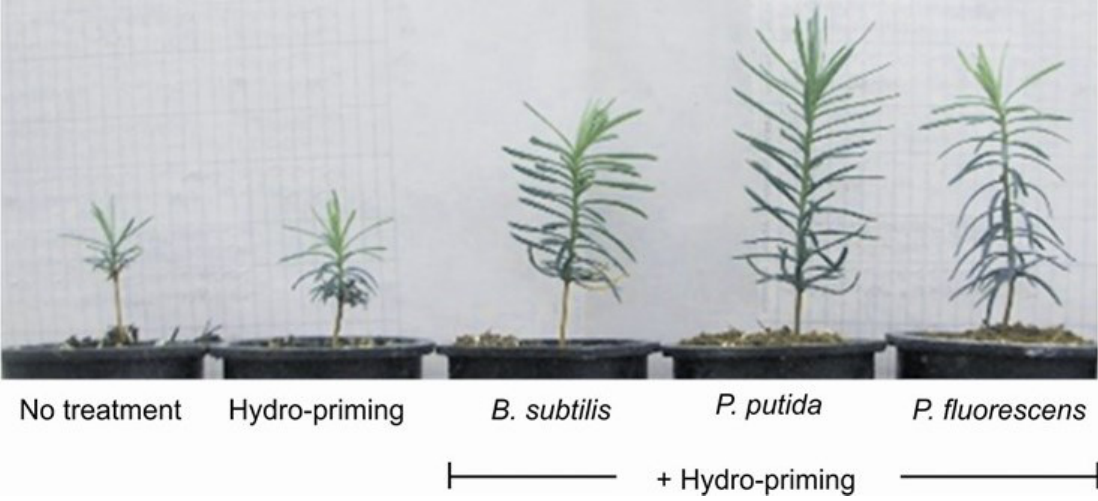
Figure 3. Photograph showing typical size of hydroprimed and bioprimed seedlings of A. hickelii (only) grown for four months in a greenhouse. No treatment = Control, only moistened with sterile distilled water. All hydropriming was for 12 h with distilled water with a constant air flow of 2.5–4 L·min −1 . Biopriming was carried out with Pseudomonas fluorescens strain JUV8, P. putida strain PpUV1and Bacillus subtilis strain BsUV in suspension of